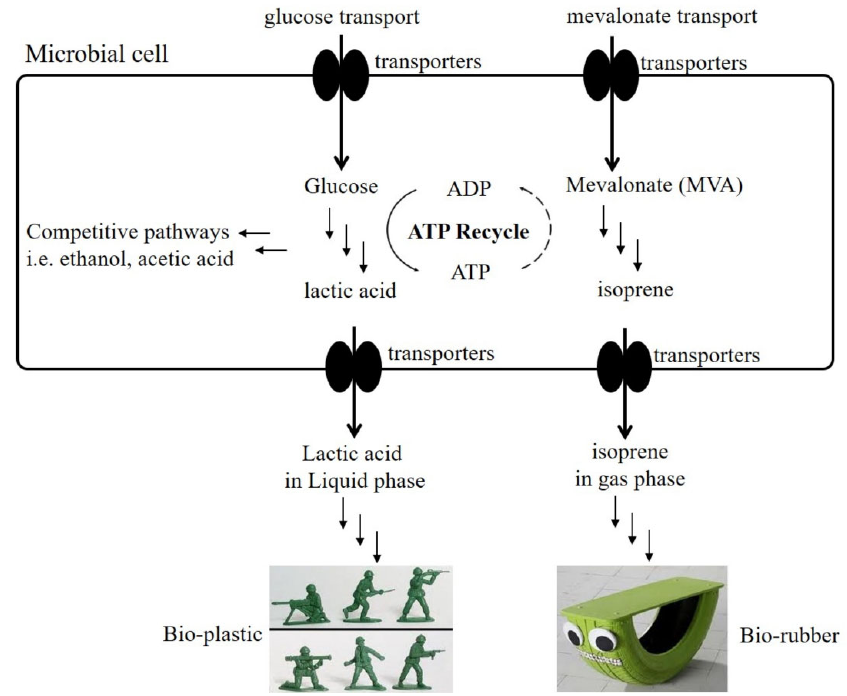
Figure 2. The routine method of the co ‐ production of isoprene and lactic acid. In the microbial cell, the lactic acid and isoprene were produced using the substrates of glucose and mevalonate, respec ‐ tively, in dual phase and under microaerobic fermentation conditions.